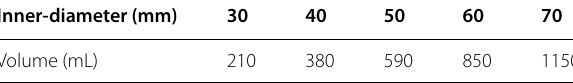
Table 2 Simulation parameters of pressure compensator Inner-diameter (mm)